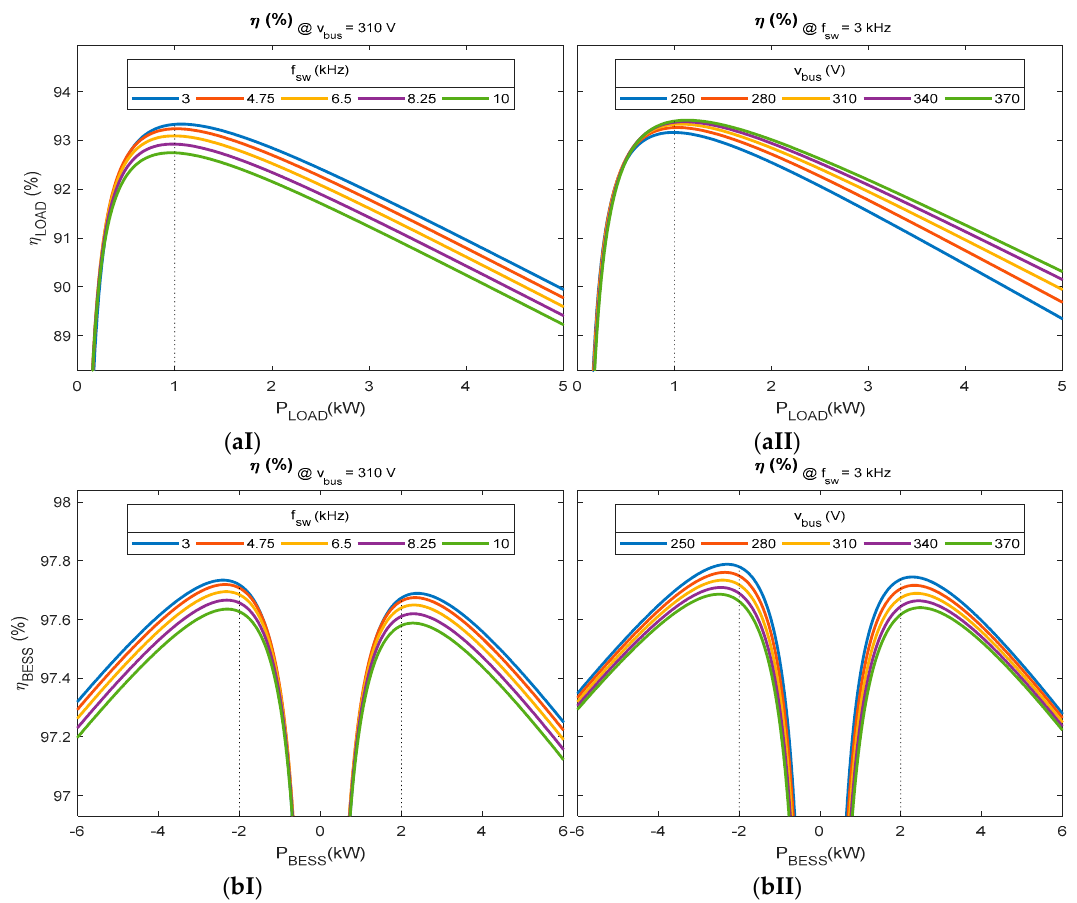
Figure 3. Efficiency curves of LOAD’s and BESS’ converters at different switching frequencies (I) and bus voltages (II): ( a ) Quadratic buck converter interfacing with LOAD; ( b ) Bidirectional converter interfacing with BESS.